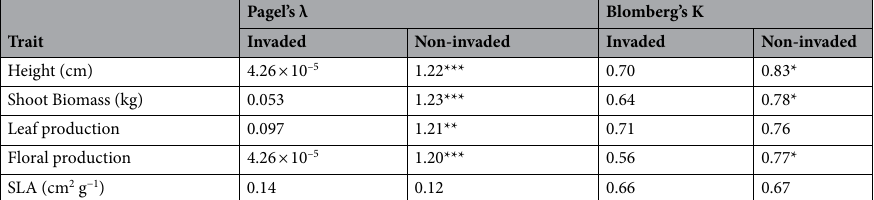
Table 3. Differences in the phylogenetic signals of native traits between invaded plots and non-invaded plots. Blomberg’s K: 1 = Brownian motion (BM), 0 = random expectation; Pagel’s lambda: 1 = BM, 0 = random expectation; p-values: * < 0.05, ** < 0.01,